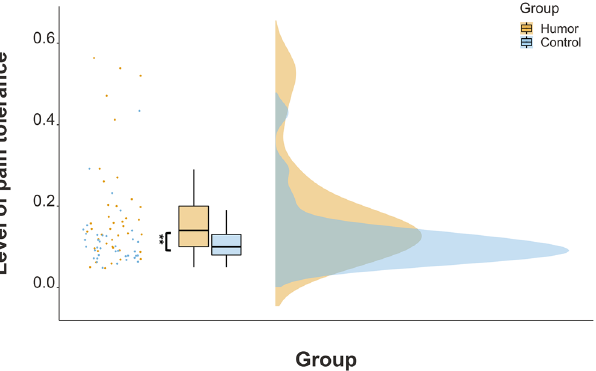
Figure 3. Pain tolerance as a function of group. Asterisks (*) indicate statistically significant differences: ** p <